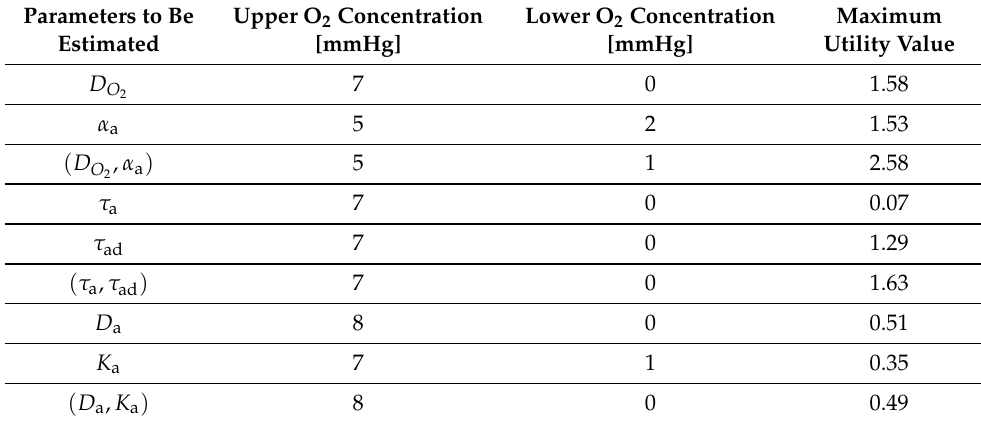
Table 4. Most useful experimental configuration for each of the parameters’ evaluation. Parameters to Be